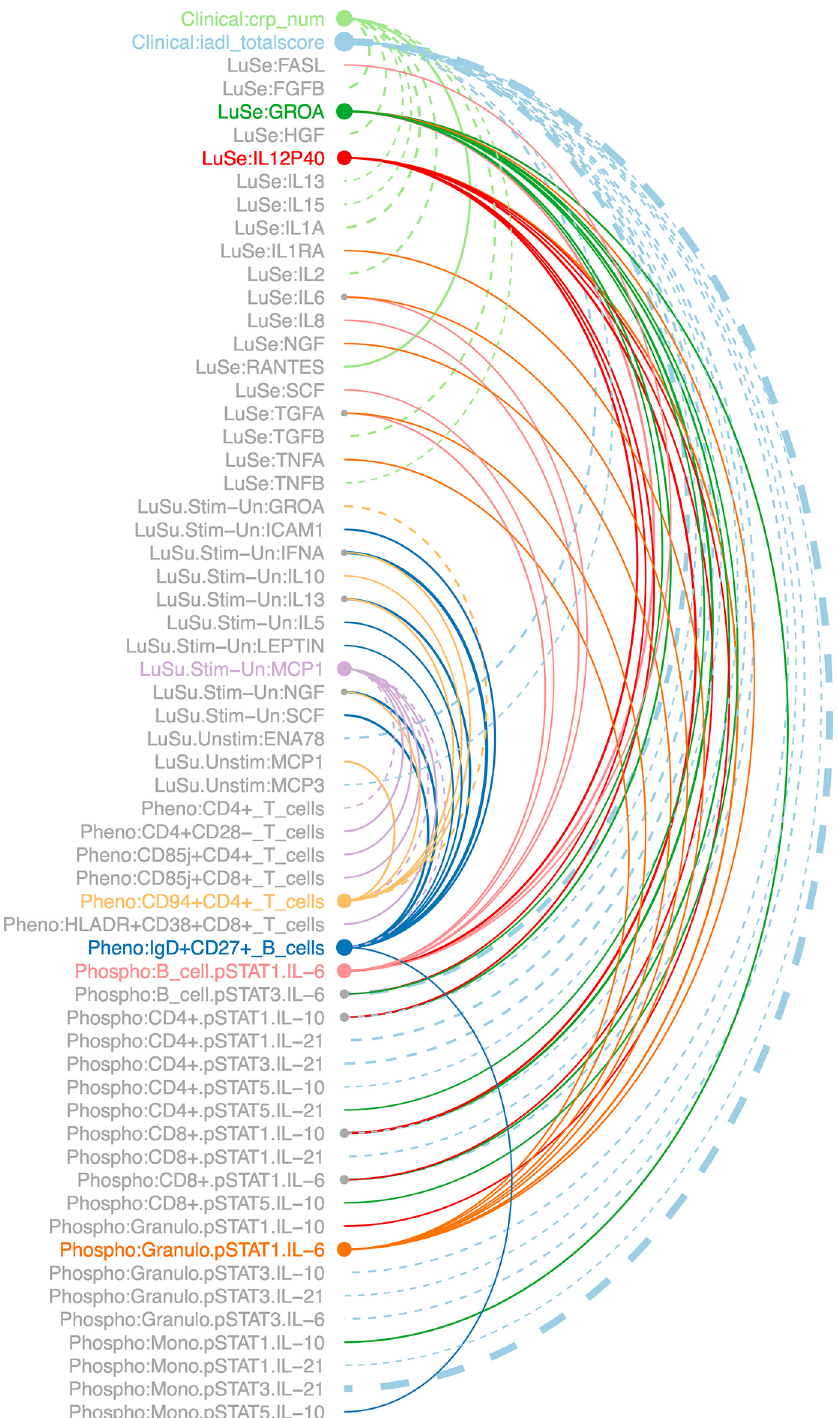
Fig 8. Associations between clinical and immunological analytes, after accounting for the effects of age, sex, and CMV status. Initially, associations were limited to the strongest 0.5% of the cross-assay associations, as defined by smallest p-values. The 3 Luminex assays were considered a single assay. We then looked for analytes having the largest numbers of associations, hereafter called connections. The diagram includes all analytes connected to at least 7 other analytes (n = 9), and the analytes to which these analytes are connected, for a total of 61 analytes. Node size is proportional to the number of